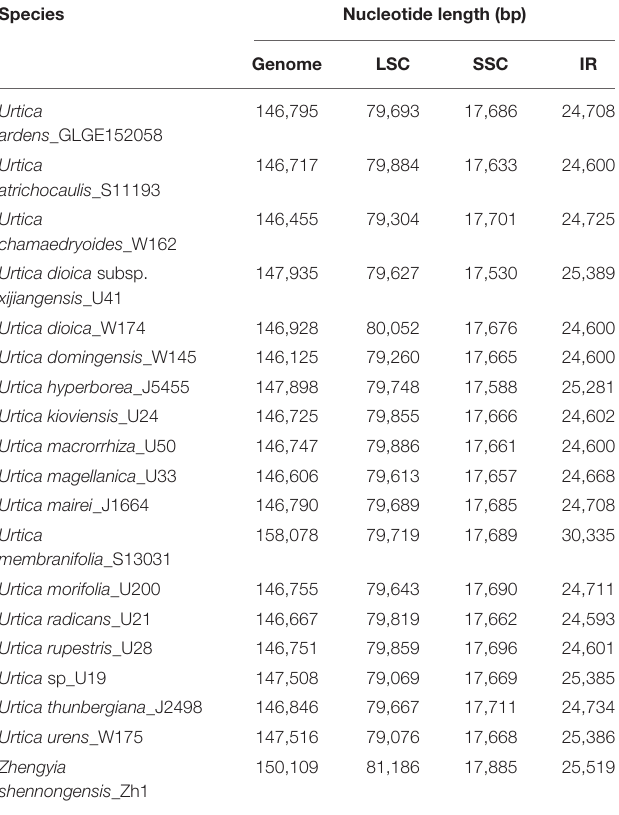
( Figure 4B ), and that of the number of SSRs ranged ( Figure 4C ). The majority of the SSRs were mononucleotides (2,627, 89.97%), with poly-A and poly-T SSR motifs being the two most frequent ( Figure 4D and Supplementary Table 5